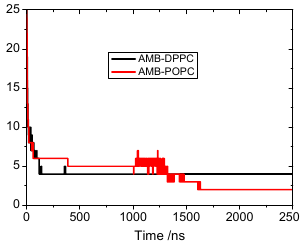
Figure 1. The number of peptide (AMB) clusters as a function of simulation time in different membrane systems: DPPC (black line) and POPC (red line).